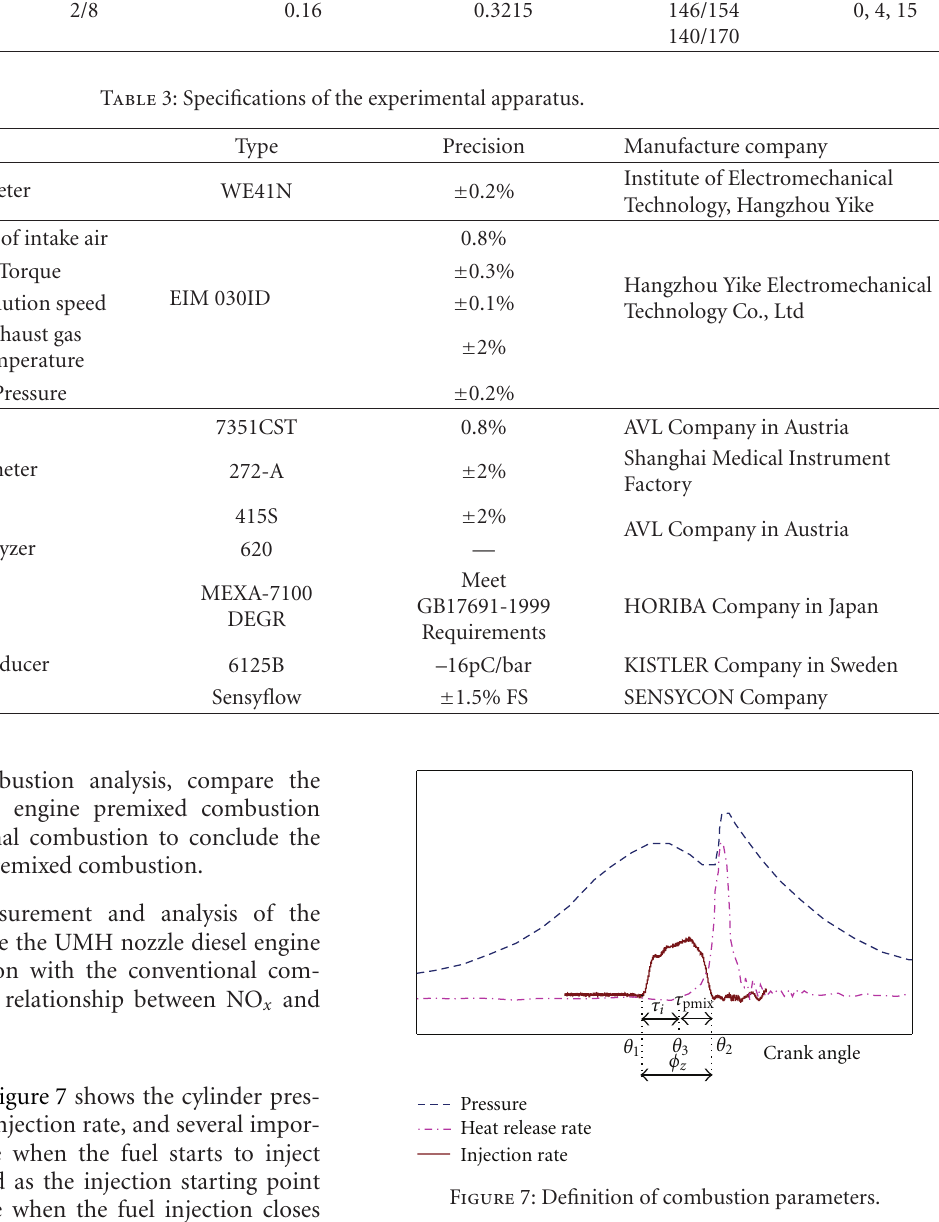
and the injection close point is defined as the premixed degree duration τ pmix ( ◦